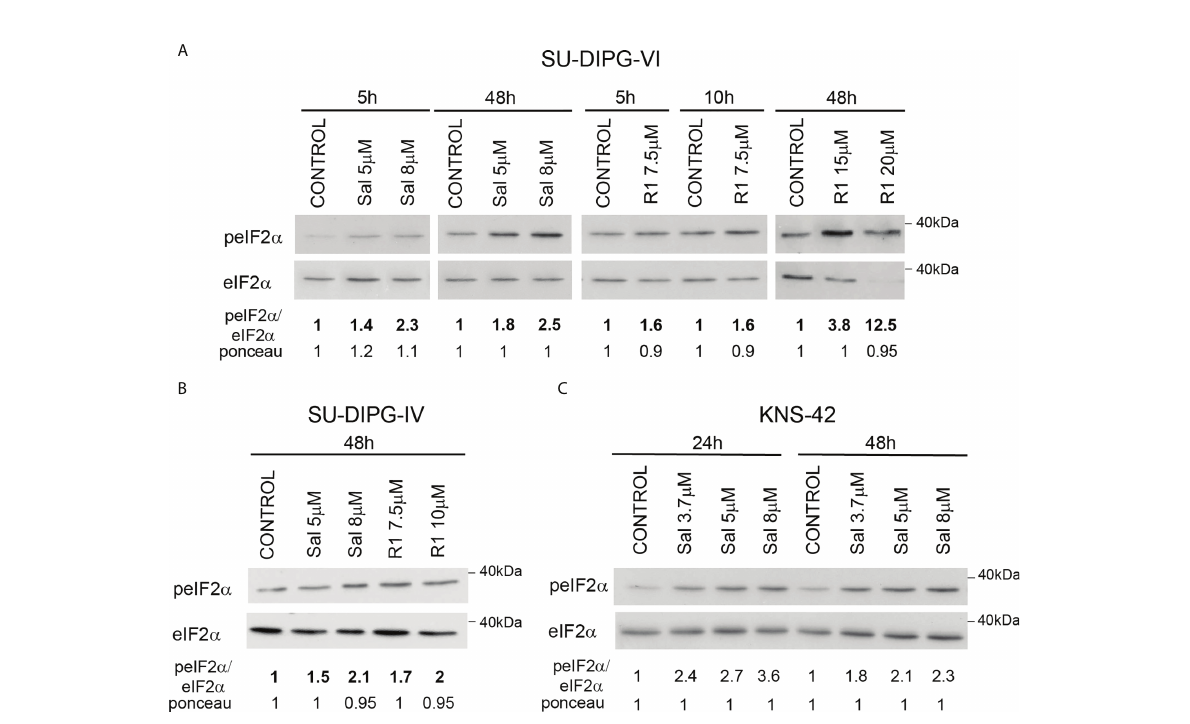
FIGURE 2 Salubrinal and raphin-1 increase P-eIF2 a : (A – C) . Cells were processed for Western blot analysis of treatment-induced changes in the ratio of peIF2 a /eIF2 a at the indicated time. Numbers at the bottom of the autoradiograms indicate changes of peIF2 a /eIF2 a and differences in